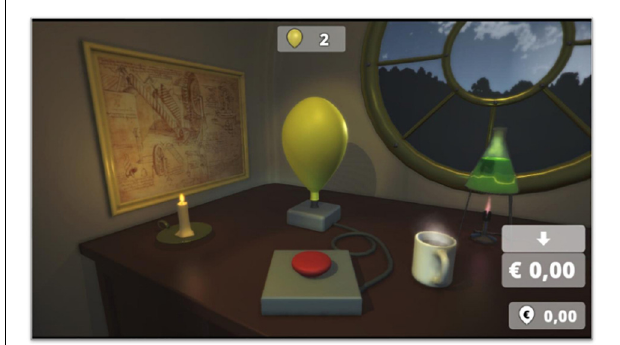
FIGURE 2 | Illustration of the BART in which participants had to decide to inflate balloons, with each pump signifying an increase in respective outcome value but also in the risk for the balloon to burst and, thus, to lose all previous earnings.